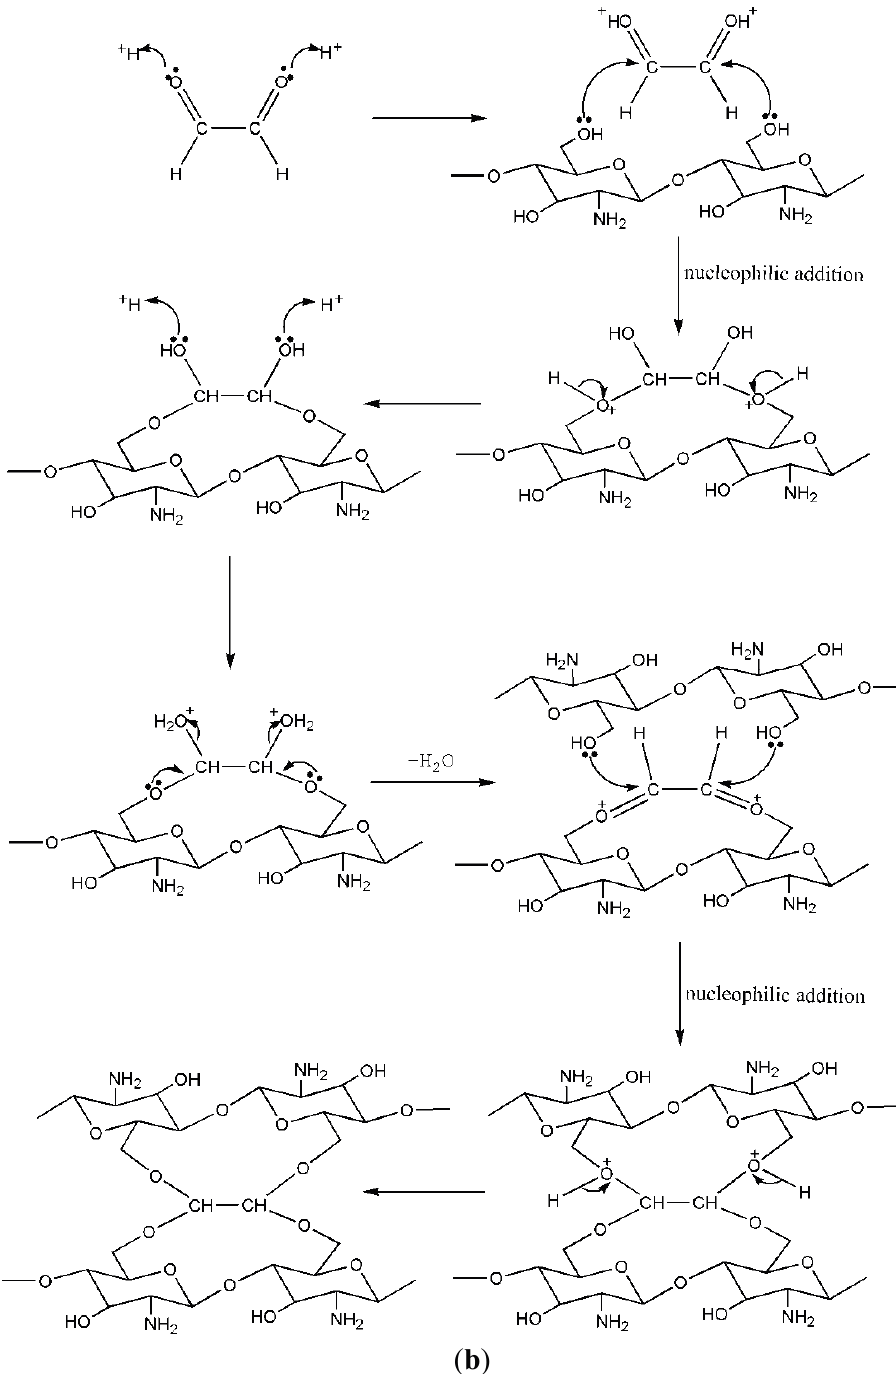
Figure 3. ( a ) Mechanism of primary reaction of chitosan and glyoxal; ( b ) Mechanism of secondary reaction of chitosan and